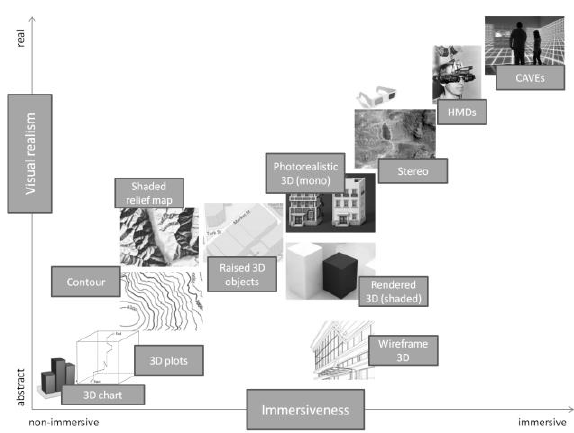
Figure 2. A rough classification of 3D visualizations based on their levels of visual realism and